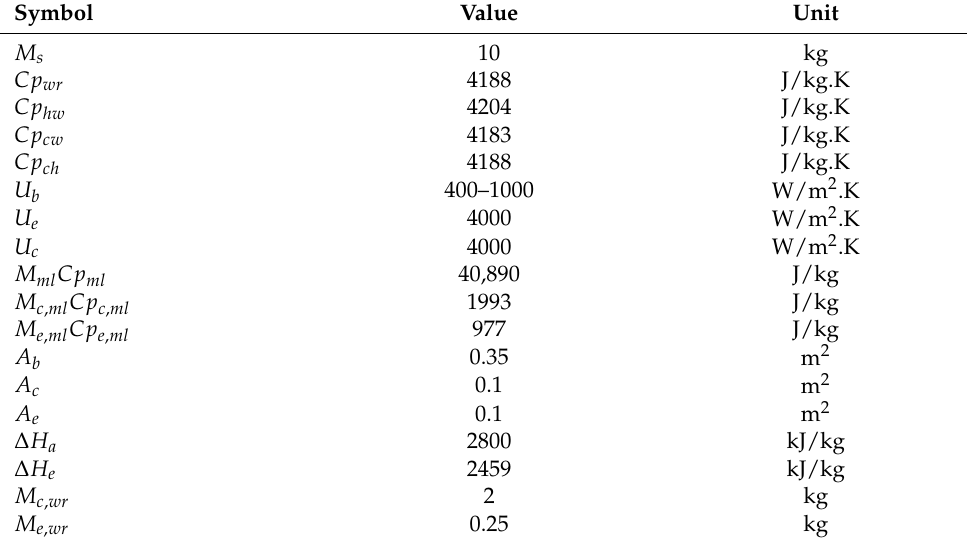
Table 1. Values adopted in formulation of the mathematical